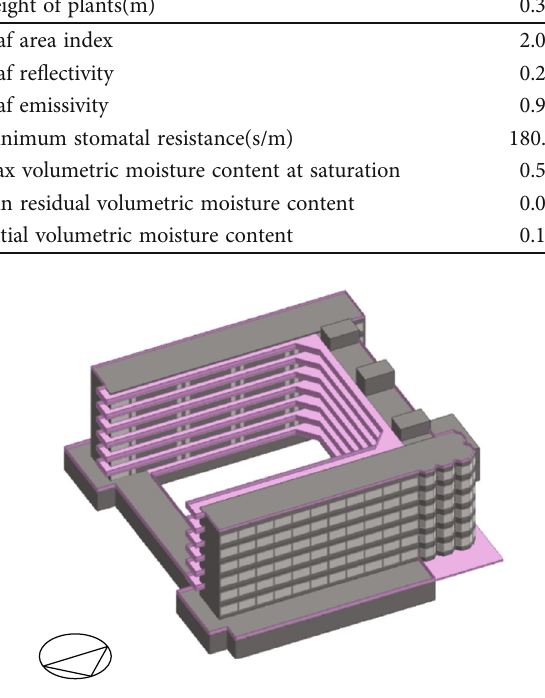
Figure 7: Building model.